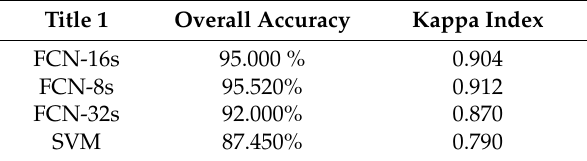
Table 2. Overall accuracy and Kappa index for FCN-16, FCN-8, FCN-32s and Support Vector Machine classifiers.